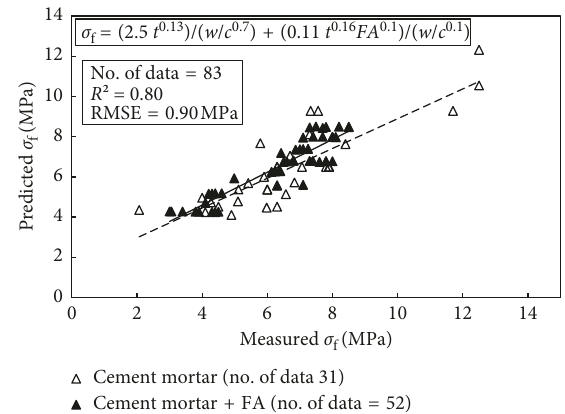
Figure 11: Relationship between measured and predicted flexural strengths for cement mortar with and without fly ash (FA).